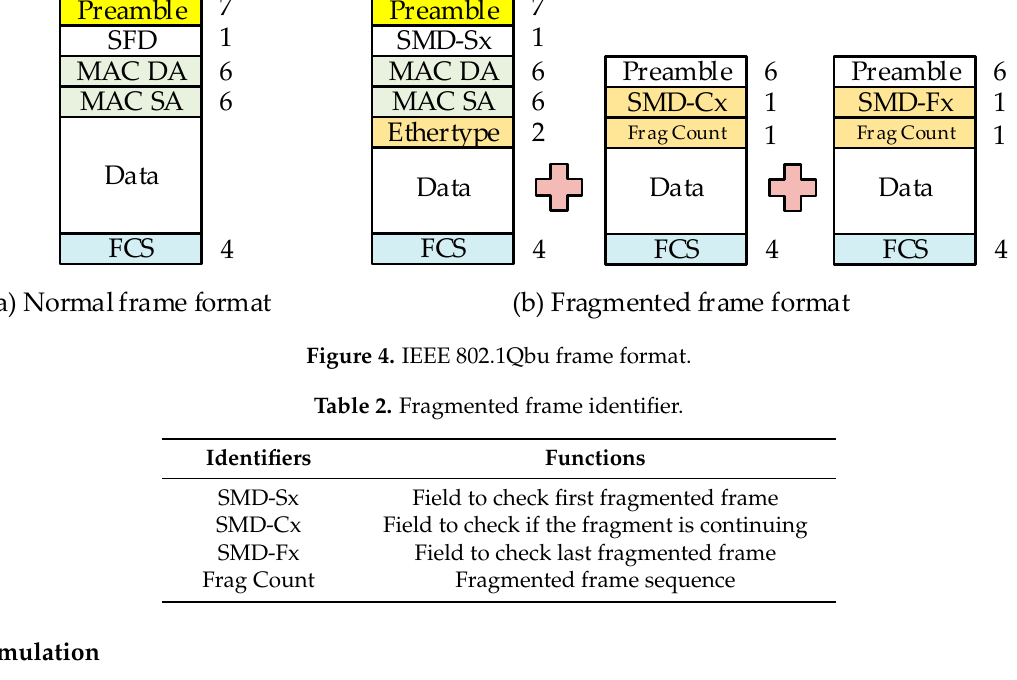
Table 2 . Fragmented frame identifier.